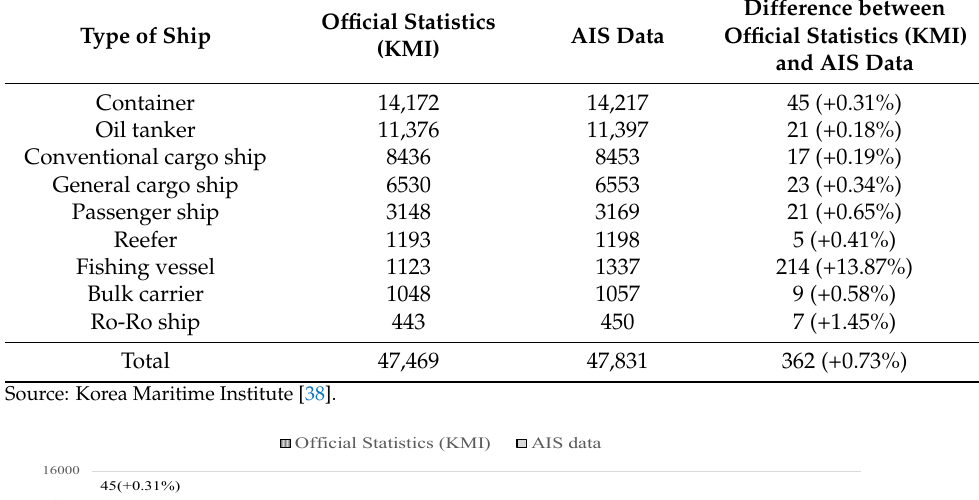
Table 2. Vessel arrivals of different types in BP in 2019.